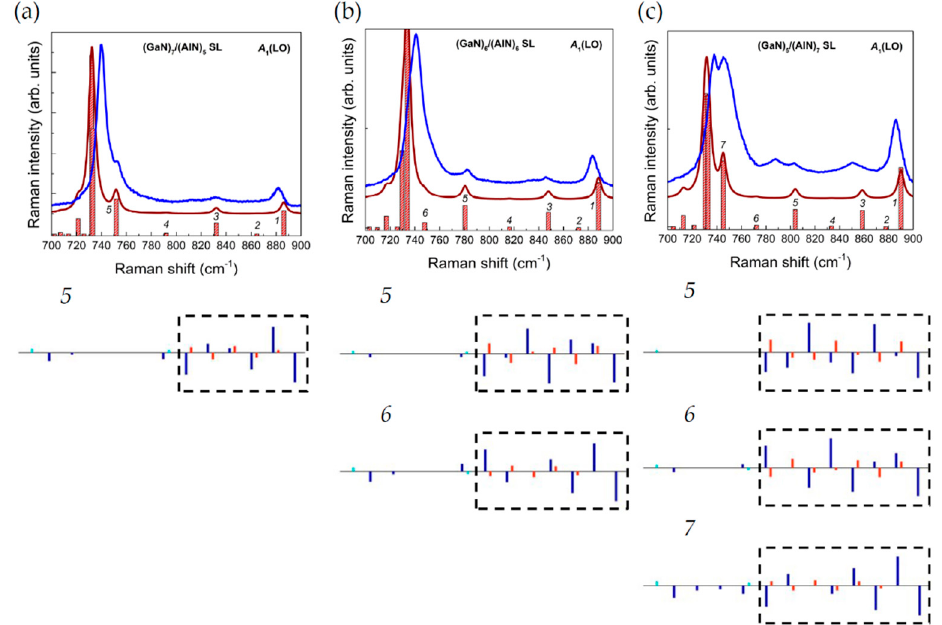
Figure 14. Frequencies and Raman intensities of the A 1 (LO) symmetry modes in the calculated spectrum in the z ( xx ) z geometry for (GaN) 7 /(AlN) 5 ( a ), (GaN) 6 /(AlN) 6 ( b ), and (GaN) 5 /(AlN) 7 ( c ) SLs (shown by bars). The solid brown line shows the averaged spectrum for the Lorentzian line shape and the line half-width of 3 cm − 1 . The blue line shows the experimental spectrum. Below the spectra, the eigenvectors of some modes are given, the numbers of which correspond to the numbering shown on the panels ( a , b , c ). Dashed lines show the AlN layers in